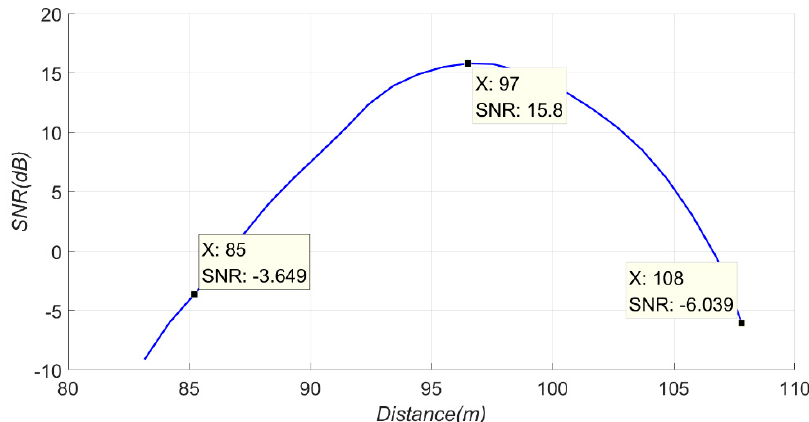
Figure 24. Approximate SNR from 84 to 108 m.